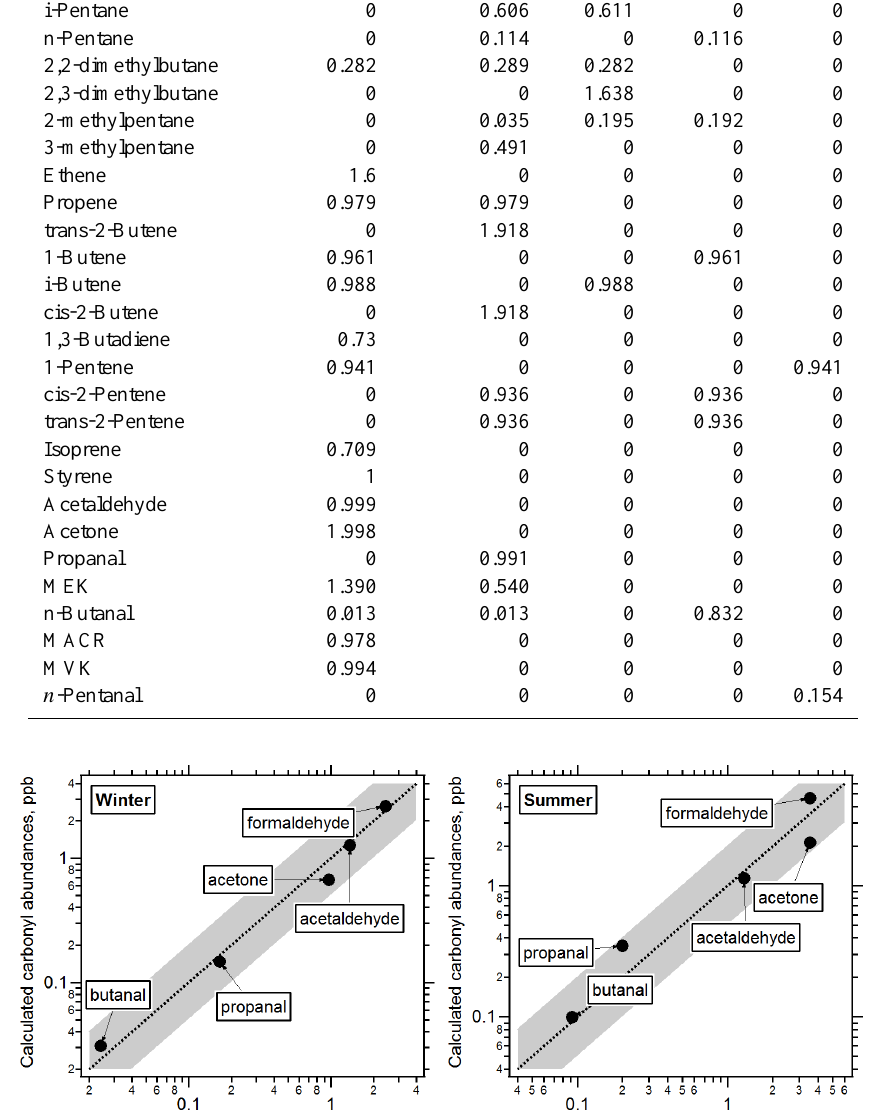
Fig. 7. Comparison of carbonyl abundances calculated based on VOCs consumptions with PMF-resolved abundances in aged factor. The grey shaded area shows an agreement within a factor of